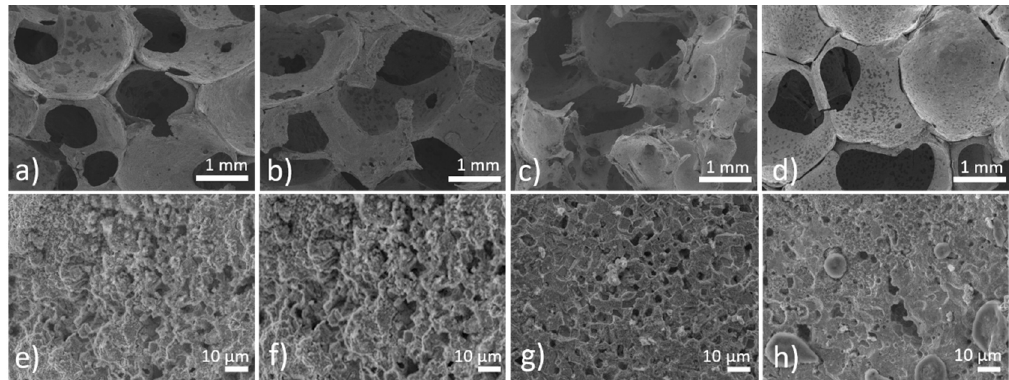
Figure 9. The SEM micrographs of the ( a , e ) Fe; ( b , f ) Fe-PEI1; ( c , g ) Fe-PEI2; and ( d , h ) Fe-PEI3 samples